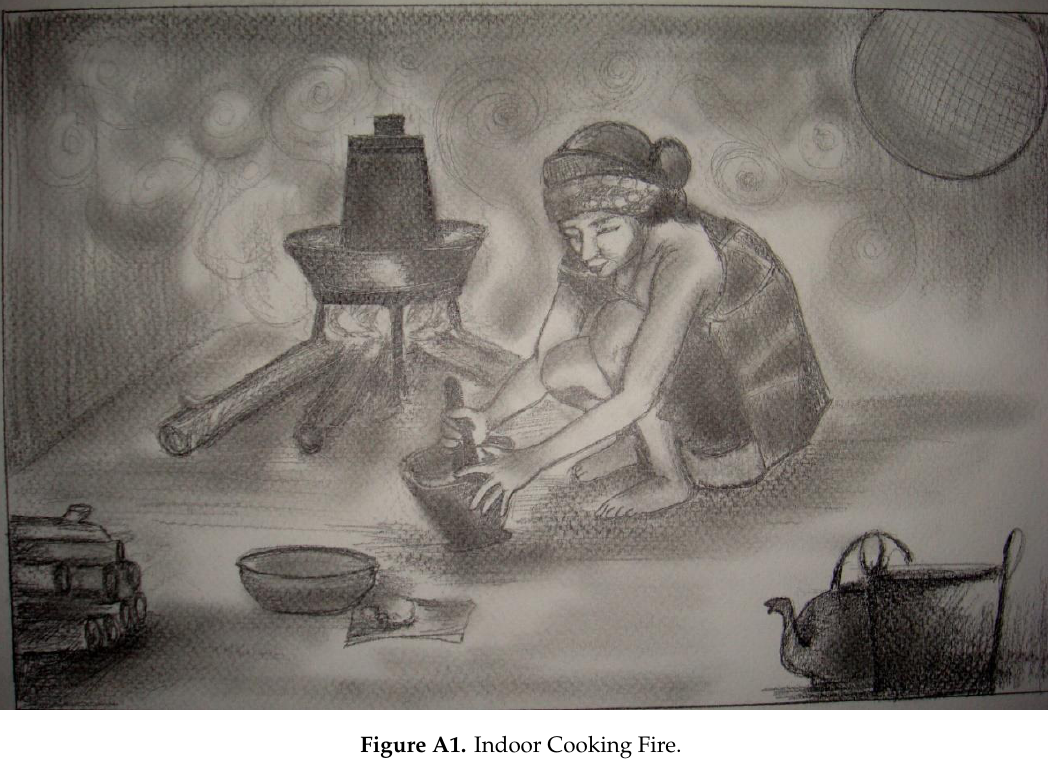
Figure A1. Indoor Cooking Fire.